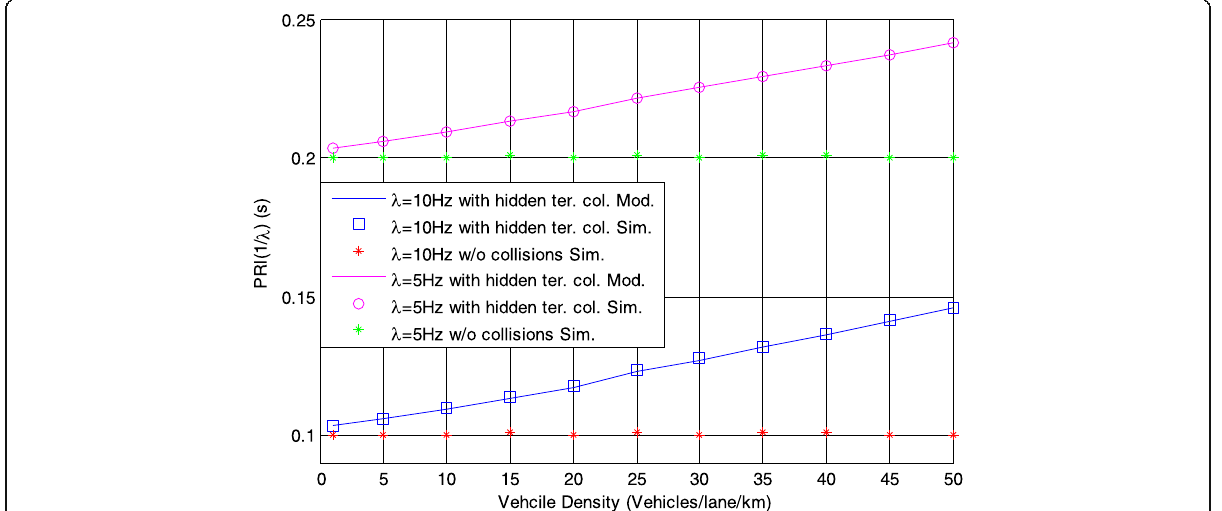
Fig. 19 Comparison of PRI from analytical model and simulation for hidden terminal collisions and without collisions with respect to vehicle